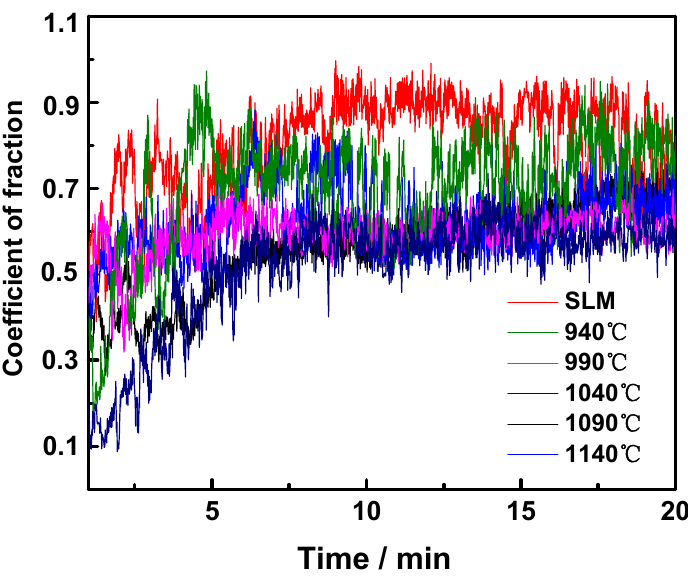
Figure 6. The friction coefficient of SLM-formed samples and samples heat-treated at different solution temperatures.